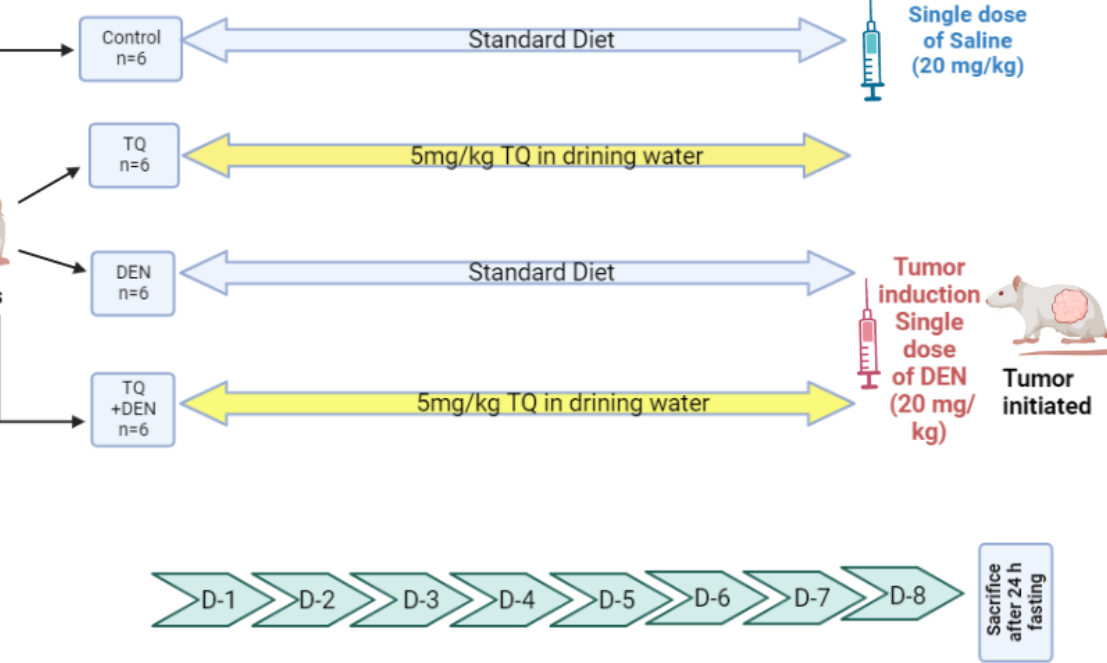
Figure 6. Experimental design. Twenty-four rats were divided into 4 groups ( n = 6). Group 1 (nega- tive control group): the rats had a regular diet and received saline ip on the 8th day. Group 2 (TQ group): Received TQ for 7 days at a dose of 5 mg/kg/day in their drinking water. Group 3 (DEN control): received a standard diet for 7 days. Group 4 (DEN + TQ): Received TQ (5 mg/kg/day) in their drinking water for 7 days. Both group 3 & 4 had DEN ip on the 8th day at a dose of 200 mg/kg.